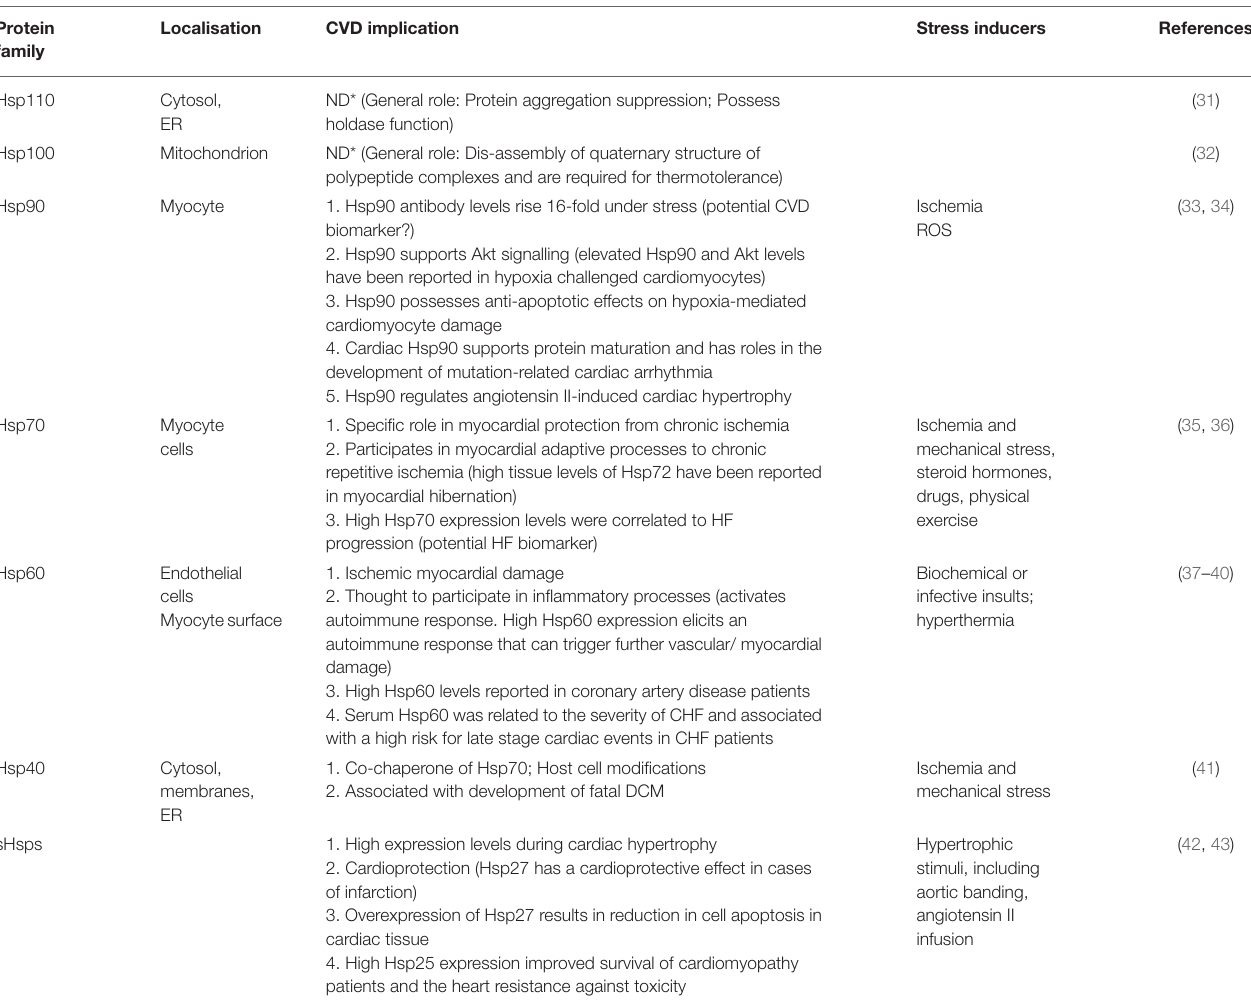
TABLE 1 | Major Hsp families and cardiovascular roles. Protein